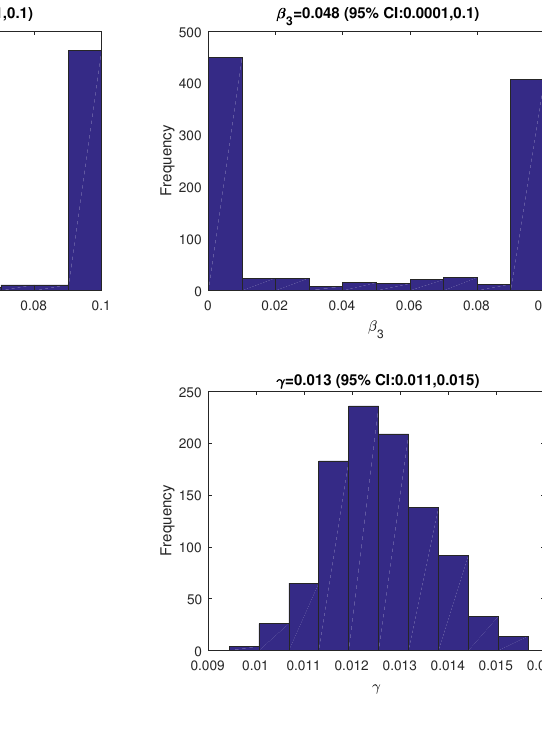
Figure 2. The values of the fitted parameters ( β 1 , β 2 , β 3 , β 4 , and γ ).